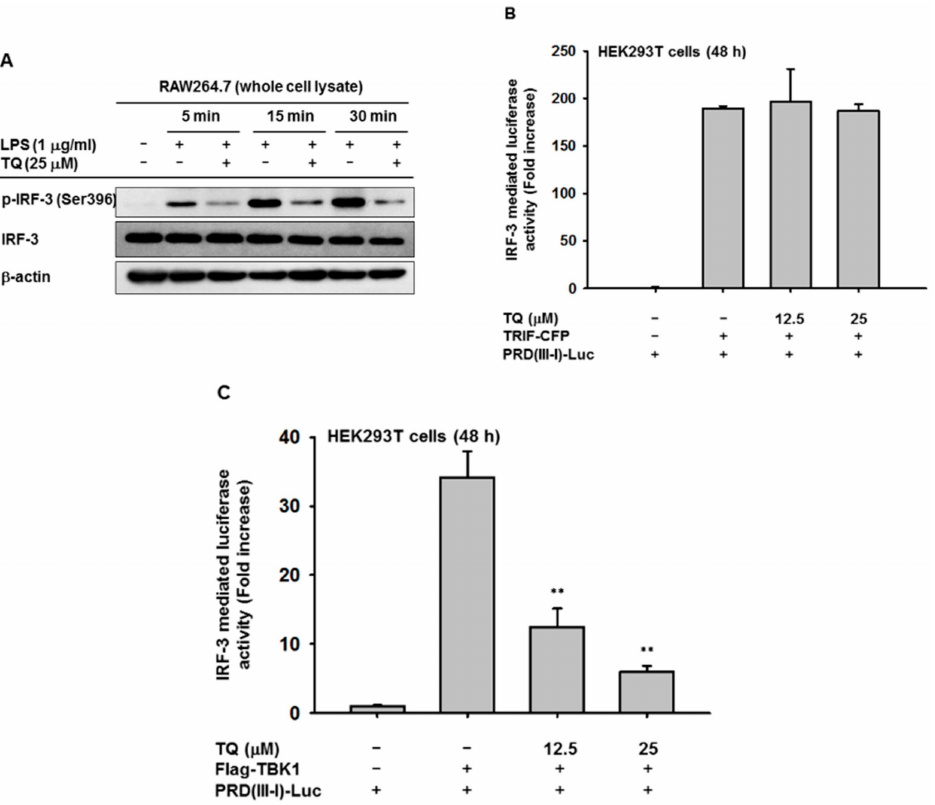
Figure 3. TQ inhibits IRF-3 activation. ( A ) RAW264.7 cells (2 × 10 6 cells/mL) were pretreated with TQ (25 µ M) for 30 min, followed by incubation with LPS (1 µ g/mL) for the indicated time points. Phospho- and total levels of IRF-3 in total cell lysate were determined by immunoblotting; ( B ) HEK293T cells (2 × 10 5 cells/mL) were cotransfected with PRDIII-I-luciferase (0.35 µ g/mL), CFP-TRIF (0.35 µ g/mL), and β -gal (0.1 µ g/mL) for 48 h; ( C ) HEK293T cells (2 × 10 5 cells/mL) were cotransfected with PRDIII-I-luciferase (0.35 µ g/mL), Flag-TBK1 (0.35 µ g/mL), and β -gal (0.1 µ g/mL) for 48 h. Luciferase activity was measured with a luminometer, and all luciferase reporter gene activities were normalized to β -galactosidase activity. All data are expressed as the mean ± SD of at least three independent experimental replicates. ** p < 0.01 compared to the control